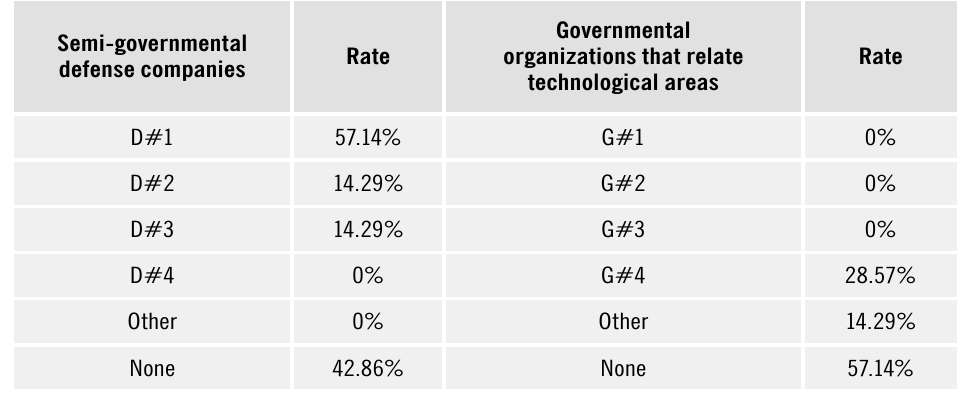
Table 4. Results of the companies for which the responding companies serve as subcontractors/product or service